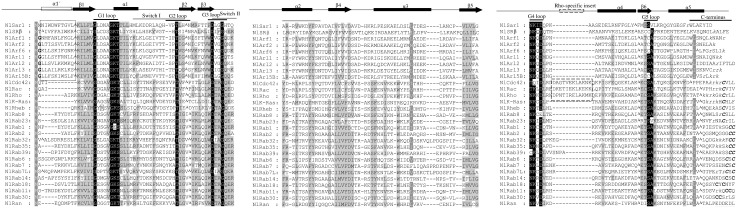
Amino acid sequence alignment of N.lugens RSGs proteins.ClustalX (2.1) program was used for multiple sequence alignment. G loop consensus residues were highlighted in black. C-terminal region cysteines were highlighted in bold italic and C-terminal basic residues (K and R) were highlighted in lowercase italic. The highly acidic C-terminal motif DEDDDL in NlRan was underlined. N-terminal glycines in positions favoring myristoylation were highlighted in bold. Gray highlighting indicated residues that were highly conserved in 90% of members. G loop and C-terminal were highlighted in black line. Switch regions were highlighted in gray line. The highly conserved residue arginine and proline, an important hallmark of Rheb and SRβ respectively, distinguishing them from other small GTPases were highlighted in frame. Rho-specific insert and α1′helix in Arf subfamily were framed with dashed lines. Secondary-structure elements were marked with arrows (β strands) and filled rectangles (helices). Amino acid omitted for optimum alignment was indicated with the ۸ symbol. Gaps have been introduced to permit alignment.